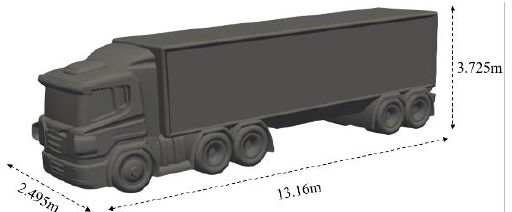
Figure 1. A perspective view of the simplified model vehicle with its dimensions .